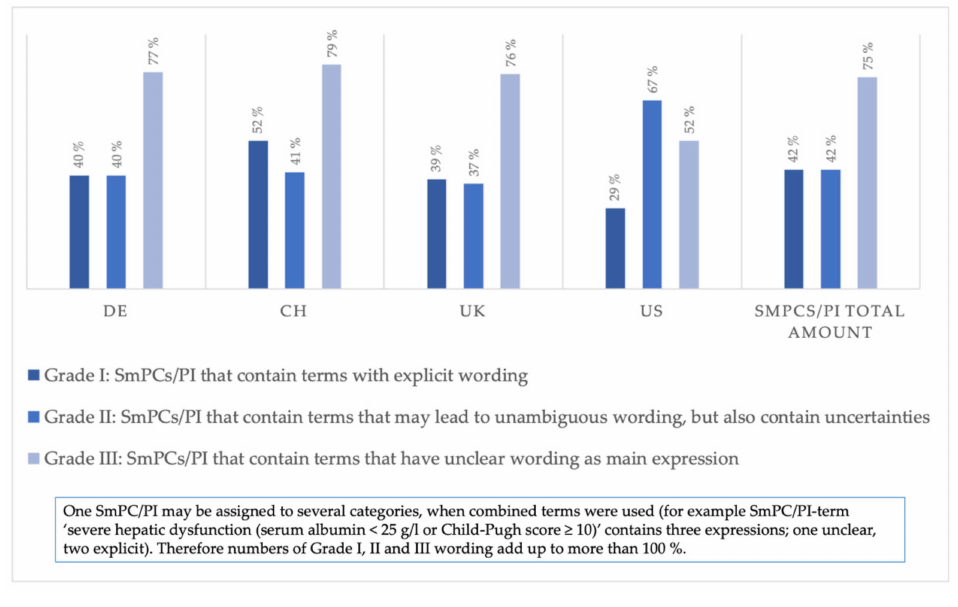
Figure 7. Portion of SmPCs/PI evaluated for explicitness of terms in all drug markets.